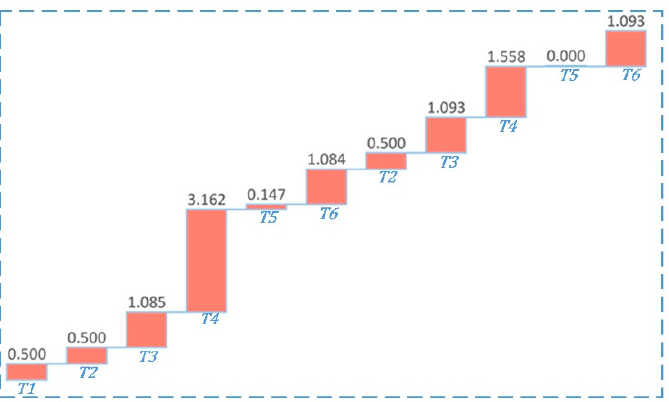
Figure 15. Average rescue time for each stage of the TPM-0.5 with 45 PDTs.